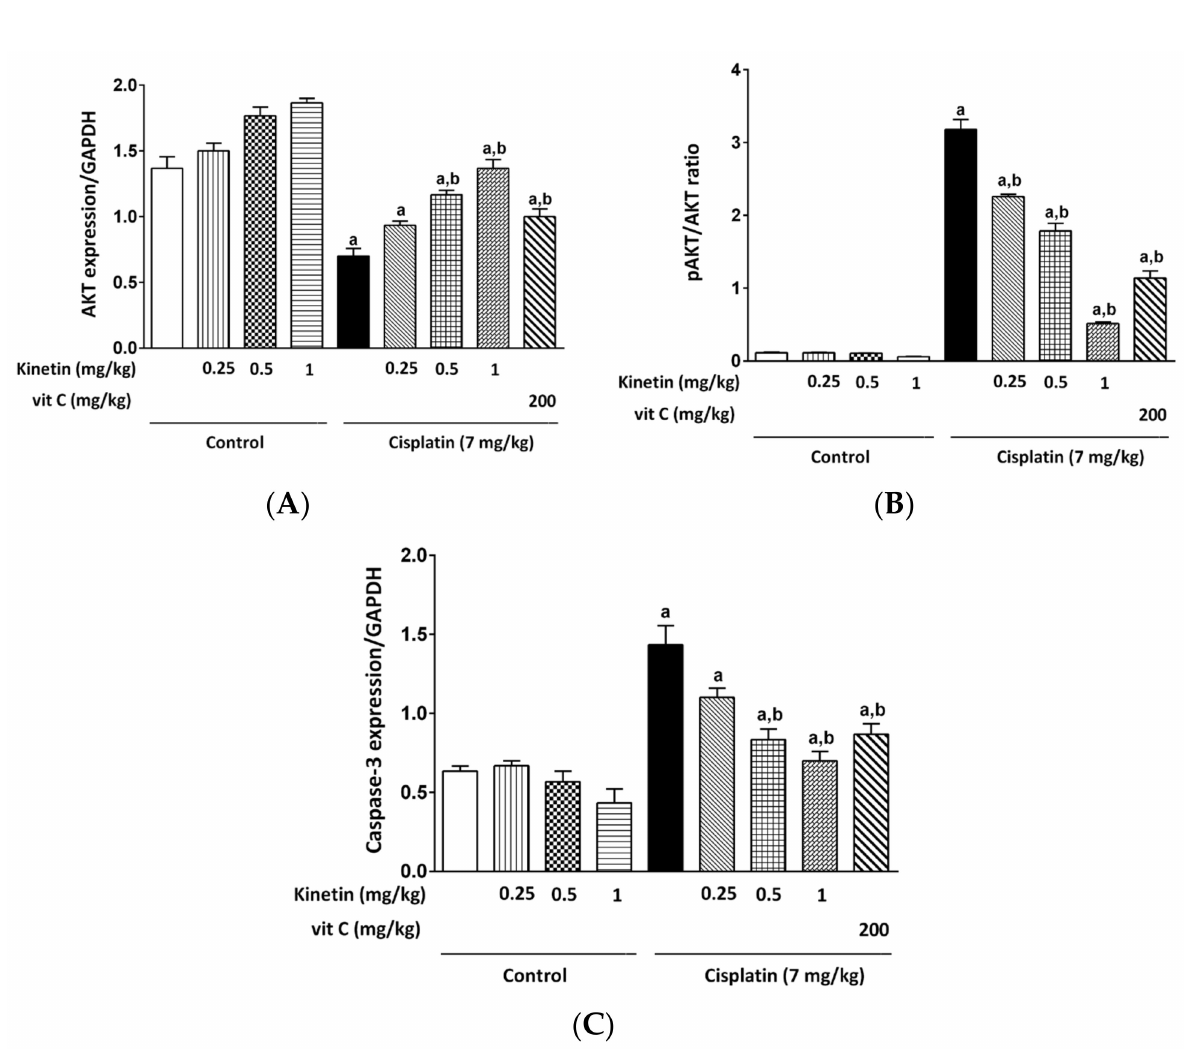
Figure 7. Effect Effect of kinetin on hepatic AKT, Caspase-3 gene expression and pAKT/AKT ratio. Effect of different doses of kinetin and vitamin C on ( A ) AKT gene expression, ( B ) PAKT/AKT ratio and ( C ) Caspase-3 gene expression. a Significantly different from control group, b significantly different from cisplatin group according to one-way ANOVA followed by Tukey–Kramer multiple comparisons test at p < 0.01, ( n = 6). Vit C: vitamin